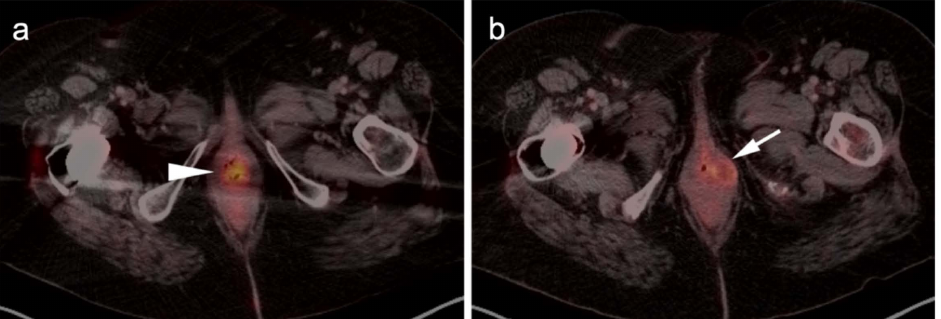
Figure 9. Vaginal melanoma. Axial FDG PET-CT images of the pelvis. ( a ) Vaginal melanoma at the introitus (white arrowhead) is mildly hypermetabolic. ( b ) One year following treatment, an intra-labial recurrence can be observed on the left (white arrow), again only mildly